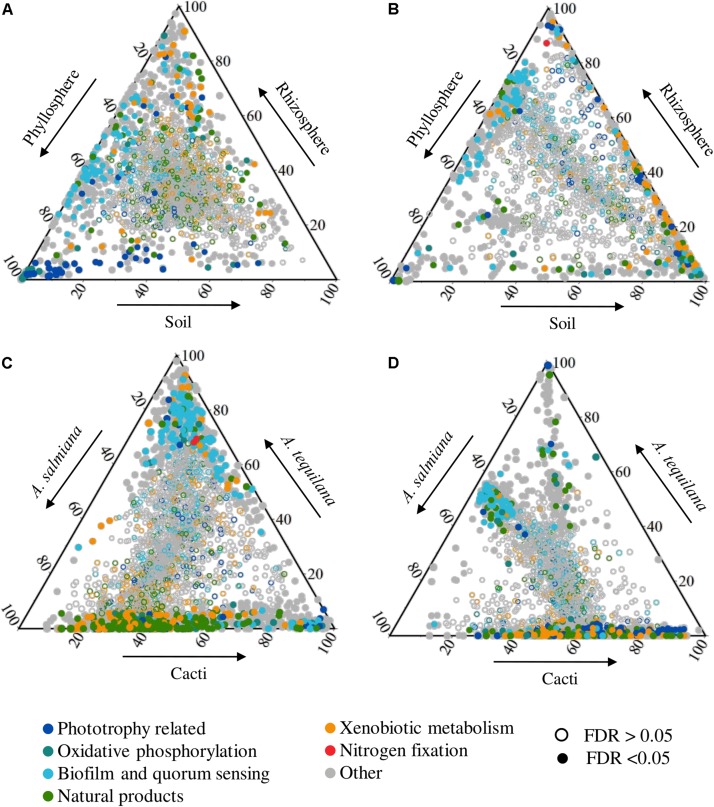
Ternary plot of differential enriched genes related to phototrophy, oxidative phosphorylation, biofilm and quorum sensing, natural products, xenobiotic metabolism and nitrogen fixation. Dots represent genes which position is defined by the ratio of its mean abundance between plant compartments (top panel) or species (bottom panel). Genes were colored based on functional groups of KO annotation and their shape is based on their FDR value in each pairwise comparison. Comparisons were made between compartments for (A) native sympatric plants and (B)
A. tequilana, and between plants for (C) the rhizosphere and (D) phyllosphere. Arrows represent the direction of the enrichment. Phototrophy: porphyrin and chlorophyll metabolism [ko00860], carotenoid biosynthesis [ko00906], photosynthesis [ko00195] and puf/puh/puc genes. Oxidative phosphorylation: oxidative phosphorylation [ko00190]. Biofilm and quorum sensing: quorum sensing [ko02024], biofilm formation-Pseudomonas aeruginosa [ko02025], biofilm formation-Escherichia coli [ko02026], flagellar assembly [ko02040], biofilm formation-Vibrio cholerae [ko05111], bacterial chemotaxis [ko02030]. Natural products: metabolism of terpenoids and polyketides, biosynthesis of other secondary metabolites KEGG pathways. Xenobiotic metabolism: xenobiotics biodegradation and metabolism KEGG pathways. Nitrogen fixation: nif genes.